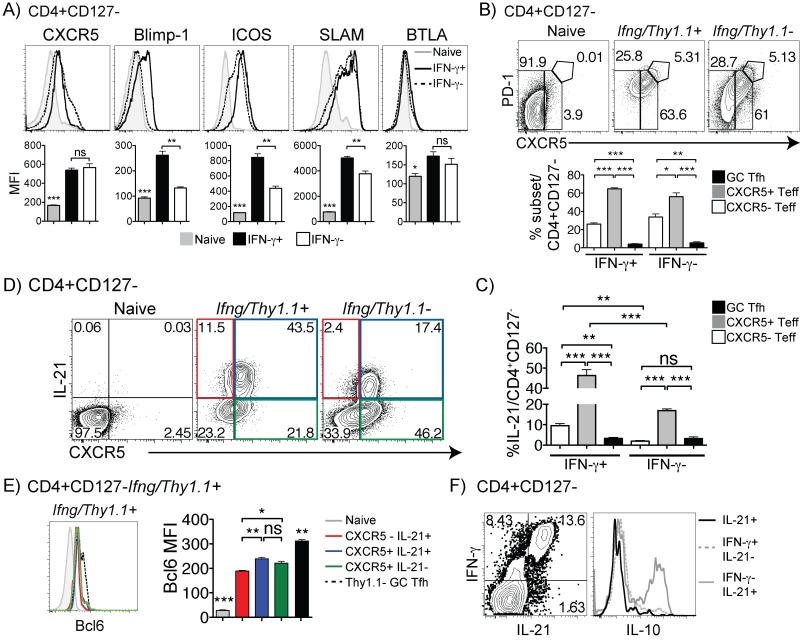
The Ifng/Thy1.1
+ T cell population expresses Tfh markers.Splenocytes from day 7 p.i (A) C57Bl/6J mice were analyzed for expression of CXCR5, Blimp-1, ICOS, SLAM, and BTLA in naïve (CD44loCD127+, grey), IFN-γ+ (black line), and IFN-γ- (dotted line) effector T cells (CD127-) as determined by intracellular cytokine staining. Bar graphs show mean fluorescence intensity (MFI). (B) Contour plots of PD-1 and CXCR5 from Ifng/Thy1.1 knock-in (KI) mice effector T cells (CD4+CD127-, as shown in Fig 2) are gated on naïve T cells from uninfected, Ifng/Thy1.1
+, and Ifng/Thy1.1
- mice. Bar graph shows percentages of Ifng/Thy1.1
+/—subsets out of total effector T cells. (C) Contour plot of IL-21 and CXCR5 expression. (D) Percentages of IL-21 within effector subsets. (E) Histogram showing Bcl6 expression in CXCR5-IL-21+ (C, red box), CXCR5+IL-21+ (C, blue box), and CXCR5+IL-21- (C, green box) subsets relative to naïve and Ifng/Thy1.1
- GC Tfh T cells. Bar graph shows average MFI of Bcl6 staining shown for each subset. (F) Contour plots for IFN-γ, IL-21 and IL-10 by intracellular cytokine staining in C57Bl/6J splenocytes day 7 p.i. Data are representative of four independent experiments with 3 mice per group. Statistical significance was obtained using Students t test. Error bar represents SEM; ★
p < 0.05, ★★
p < 0.01, ★★★
p < 0.001, ns = not significant.